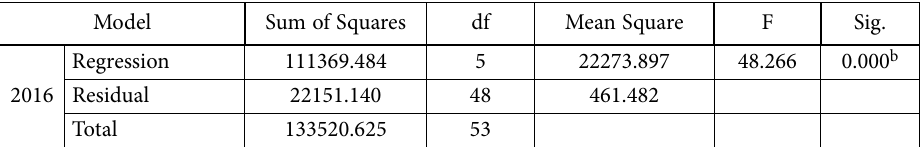
Table 6. ANOVA test of the model for 2016 Model Sum of Squares df Mean Square F Sig.